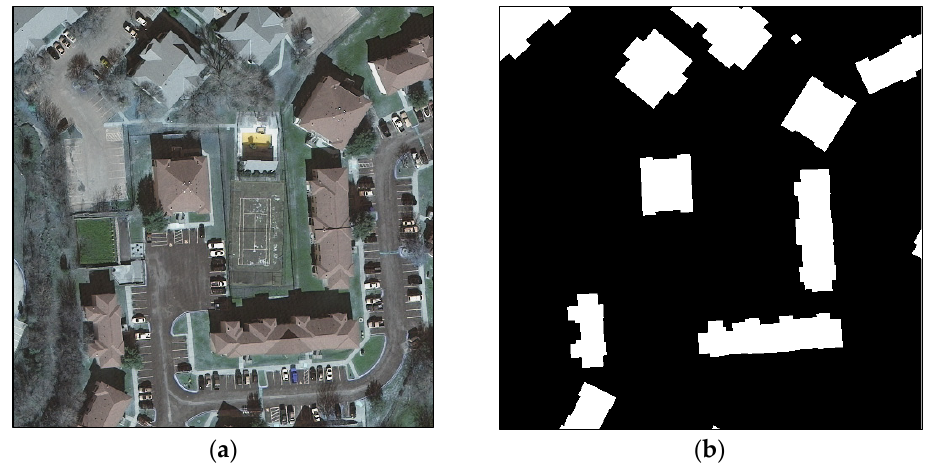
Figure 4. Aerial image labeling dataset ( a ) Sample image; ( b ) Semantic segmentation mask, buildings are marked in white.